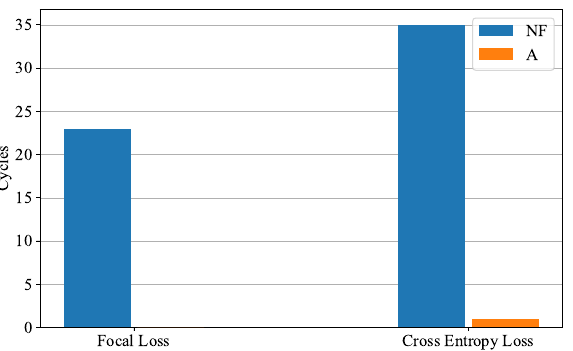
Figure 9. Sample prediction errors for time series no. 1. The models trained with cross − entropy loss and focal loss both have difficulty in accurately predicting the NF class. The model trained with cross − entropy loss fails to predict thirty − five NF samples and one fault A sample. The model trained with focal loss only incorrectly predicts a single NF